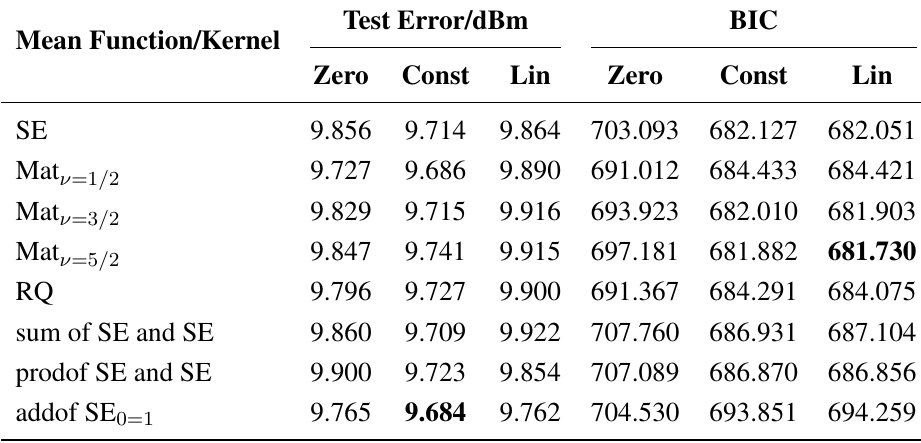
Table 2. Test error and BIC of a Gaussian process regression for different Gaussian process models trained with Indoor data. Model measures are averages over several access points and 10-fold cross-validation. The lowest values are highlighted.